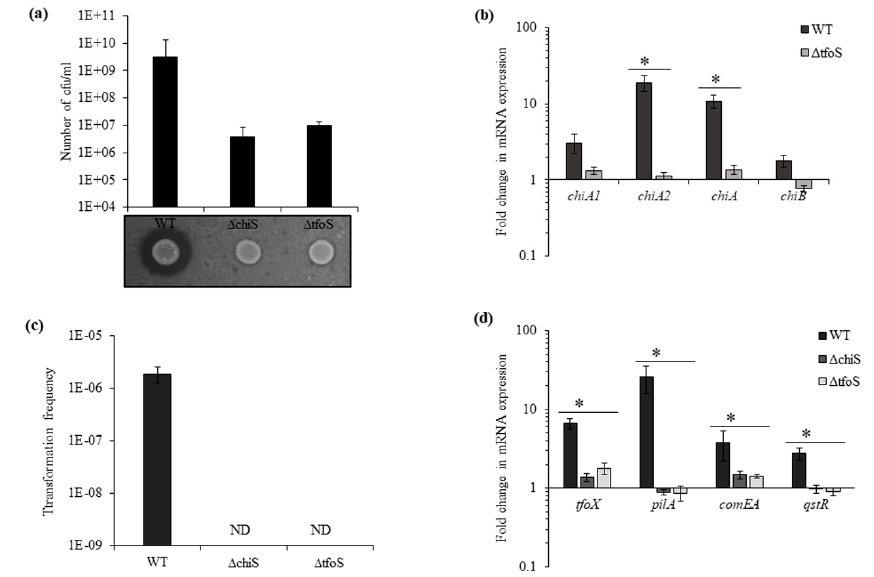
Figure 3. Transmembrane regulators ChiS and TfoS are essential for growth and natural transformation in the presence of chitin. ( a ) Growth of the indicated isogenic mutants and WT in DASW with chitin as sole carbon source after 48 h and chitinase activity on colloidal chitin plate. ( b ) The relative expression of four chitinase genes at mRNA level was checked for the ∆ tfoS mutant compared to the WT strain. recA was used as an internal control. Each bar indicates the mean ± SE of three independent experiments. Asterisks represent p < 0.05. ( c ) WT and isogenic mutant strains ∆ chiS and ∆ tfoS were naturally transformed in the presence of shrimp chitin flakes. ND = not detected. ( d ) The relative expression of competence genes tfoX , pilA , comEA and qstR at mRNA level was checked for WT, ∆ chiS and ∆ tfoS mutant. Each bar indicates the mean ± SE of three independent experiments. Asterisks represents p < 0.05, where fold change in mRNA expression between wild type and mutant was significantly a ff